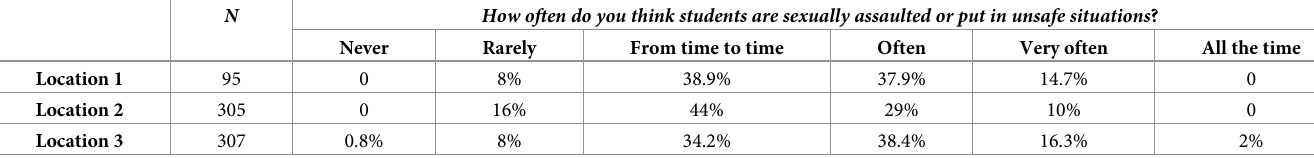
Table 2. Participants’ estimations of SA frequency in student population in all three study locations.